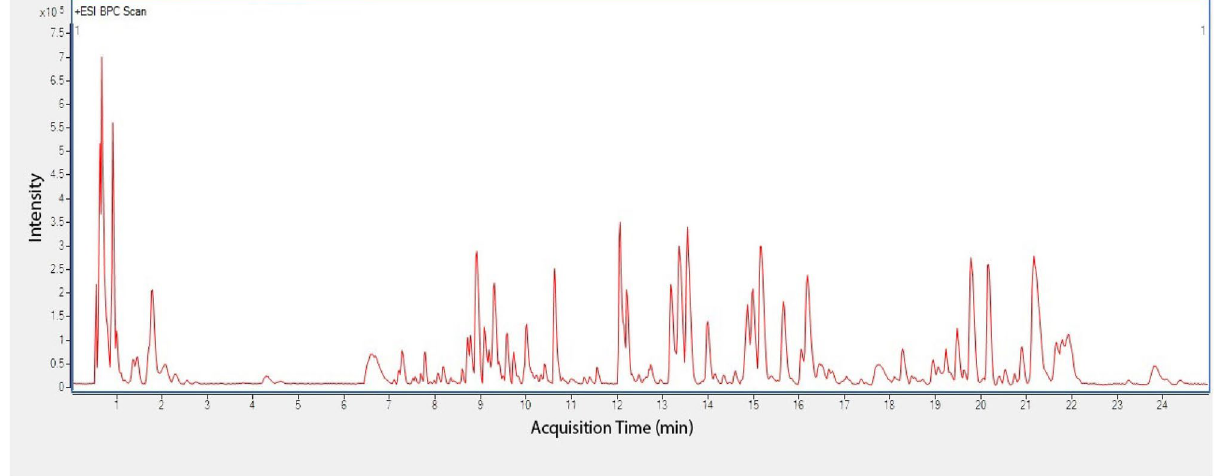
Figure 3. Base peak chromatogram (BPC) of the methanol extract of Nephrolepis